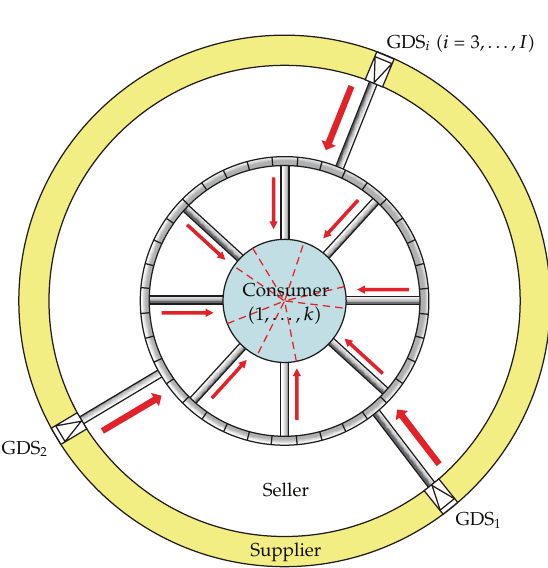
Figure 1: A diagram of the gas distribution network under